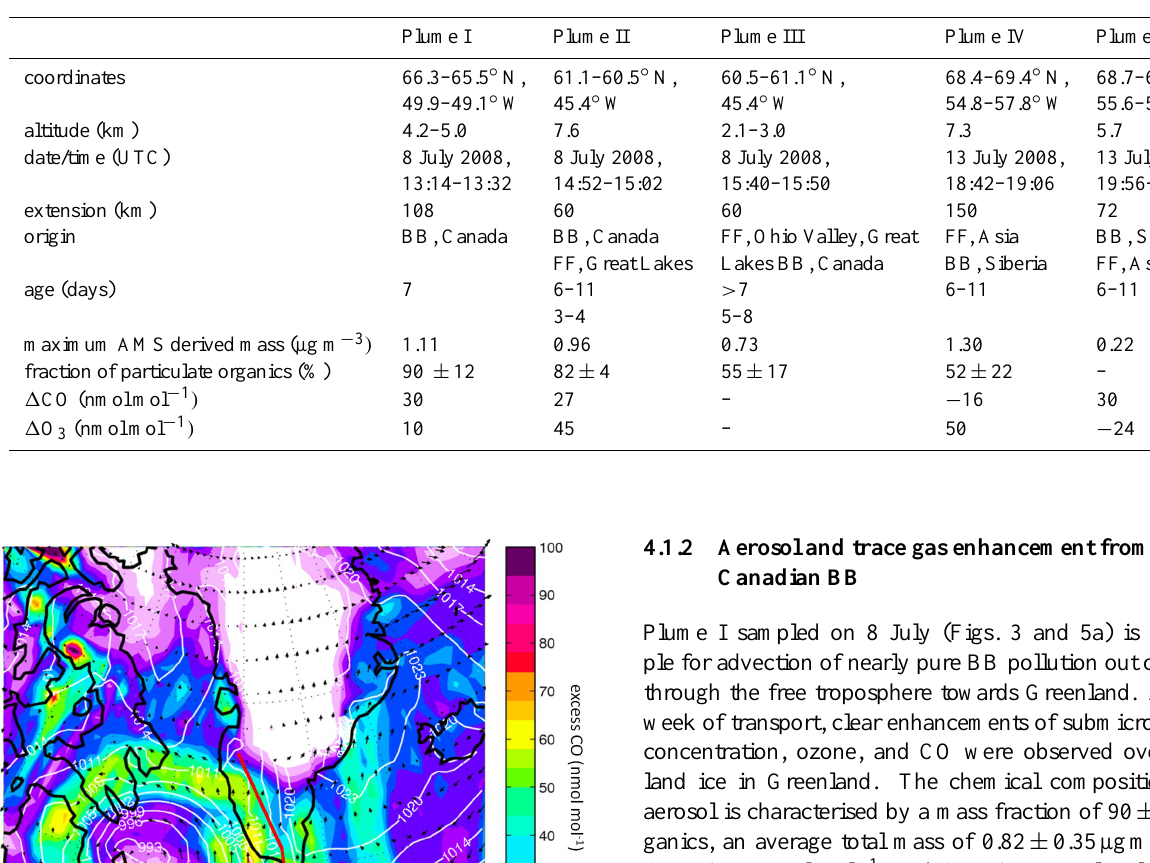
Table 4. Overview of campaign characteristic pollution plumes (discussed in detail in Sect. 4).